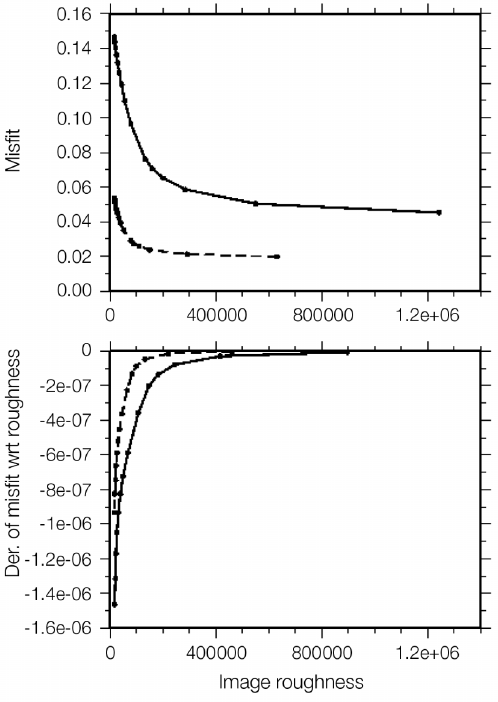
Fig. 6. L -curves ( e.g. , Hansen, 1998) associated with the Harvard (dashed lines) and Utrecht (solid lines) databases. The image roughness is defined as by Boschi (2001, Section 2.2.1) or Trampert and Woodhouse (1995, eq. (21)). Misfit is defined as 1 minus the variance